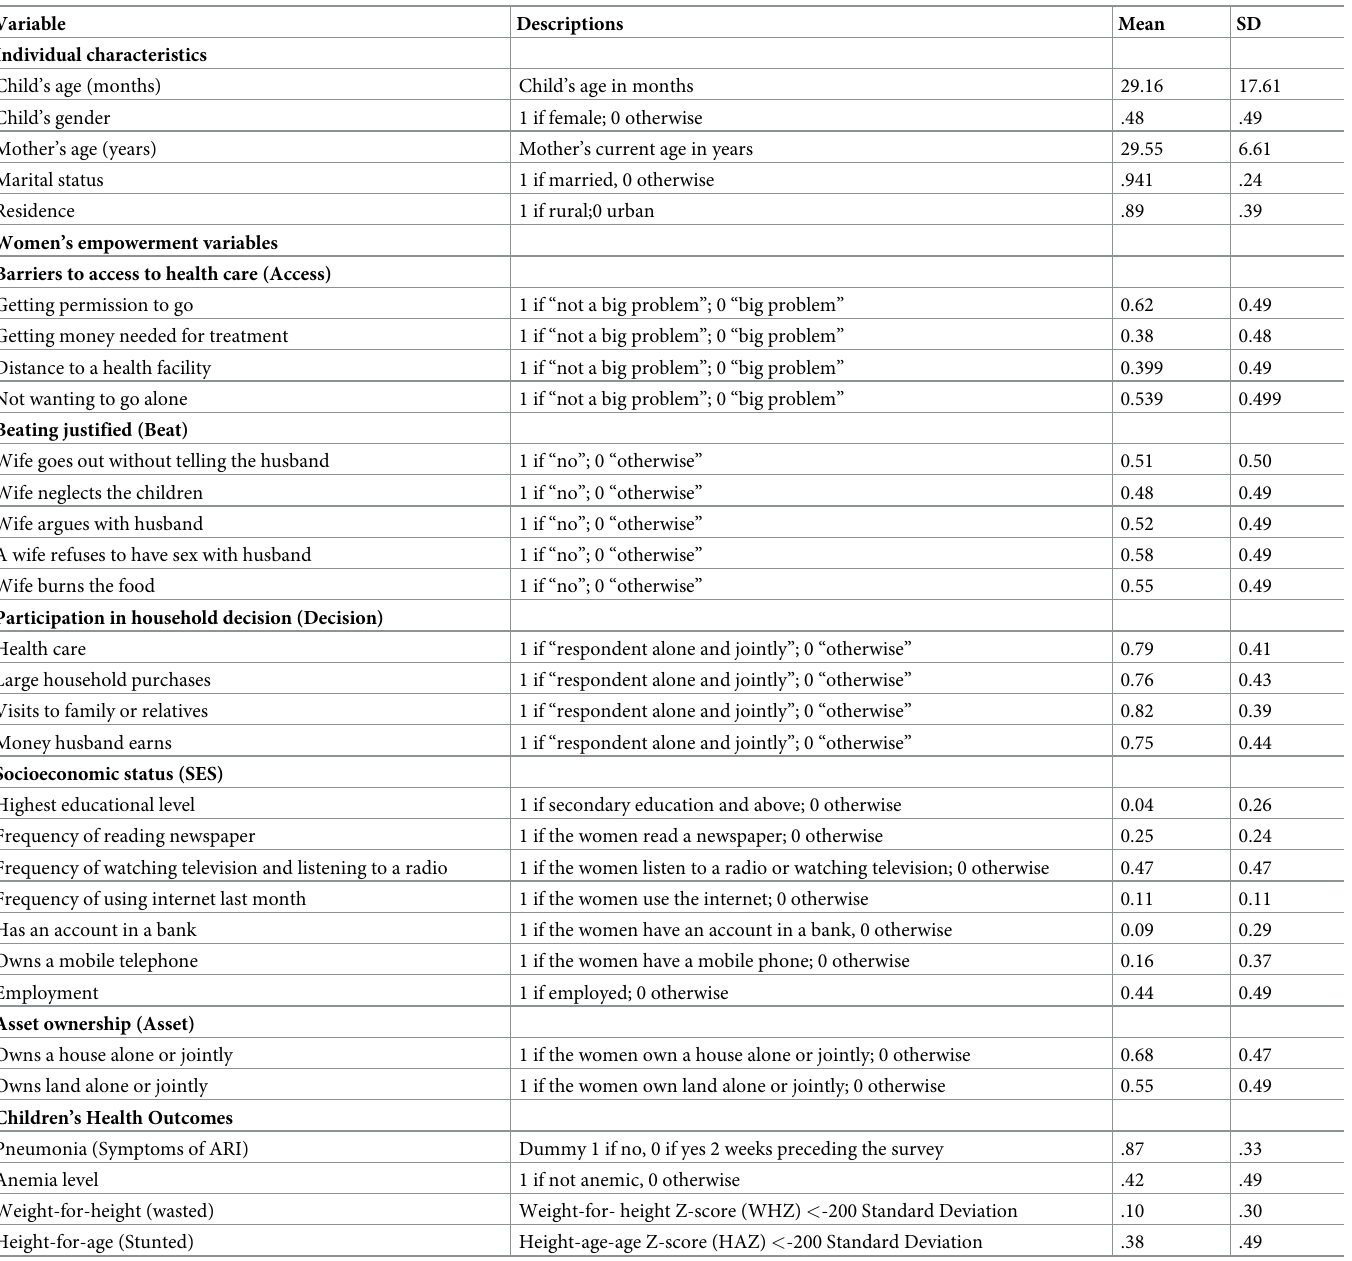
Table 1. Descriptive statistics (Ethiopian Demographic and Health